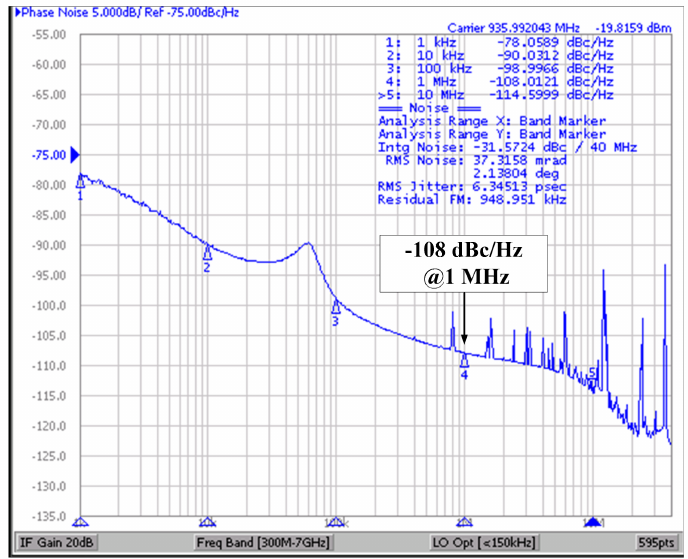
Figure 14. Measurement of injection-locked phase noise at center frequency.